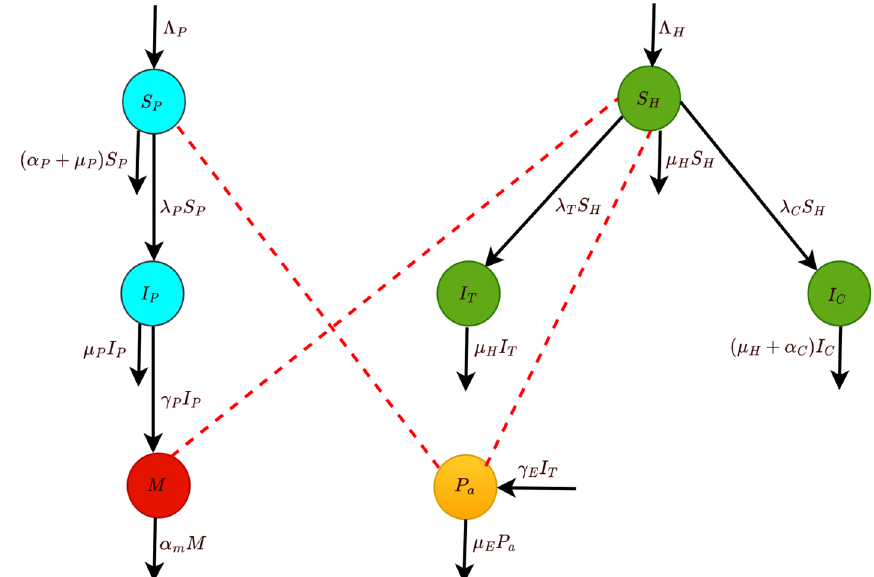
Fig. 1 Model flow chart for transmission dyamics of Taenia solium taeniasis and